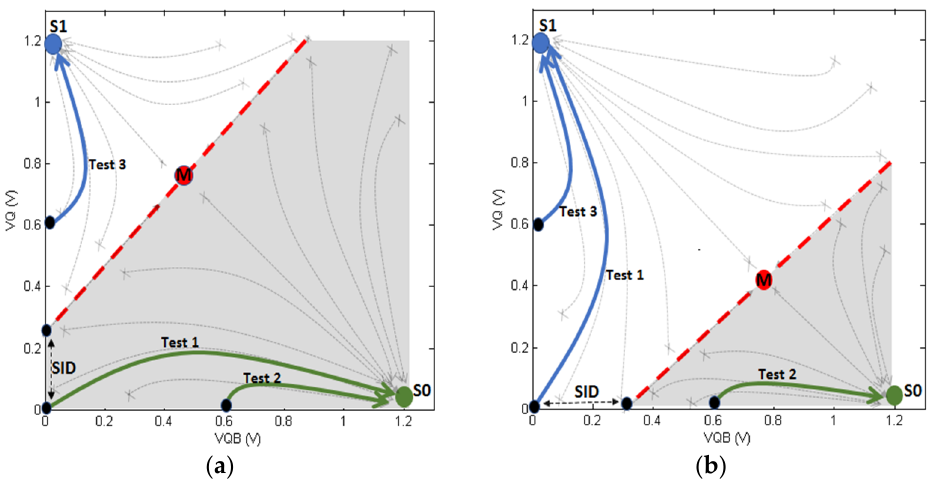
Figure 6. The suggested tests and SID metric are provided in the phase space of memory cell evolution: ( a ) for an asymmetrical cell with a propensity towards logic ‘0’, and ( b ) for an asymmetrical cell with a tendency toward logic ‘1’.